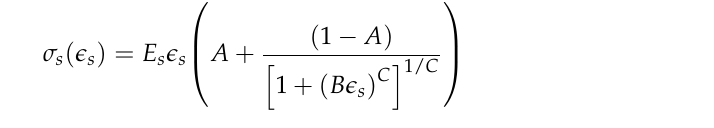
( b ) Figure 7. Comparison of experimental and analytical results: ( a ) steel strand; ( b ) smart strand. 5. Conclusions The load-strain model of the strands was analytically derived considering the case where the core and helical wires are made of different materials, such as in the smart strand. This model can be applied not only for linear materials but also for nonlinear materials. Moreover, all the parameters determining the shape of the strands, such as the diameter of the core and helical wires and the pitch, can be considered. The effect of the bending moment and torsional moment of the helical wires on the overall load within the range of geometric shapes shown by actually used strands was verified to be negligible,